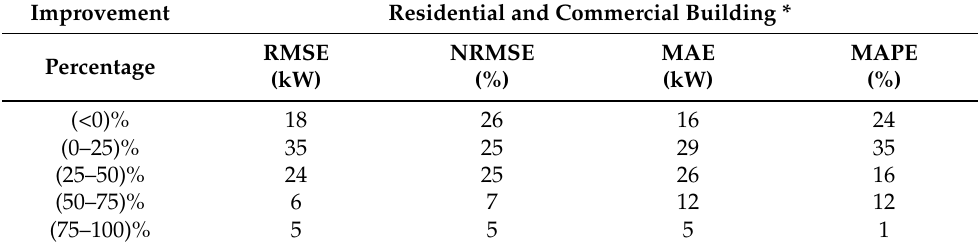
Table 6. Improvement (%) distribution of the testing